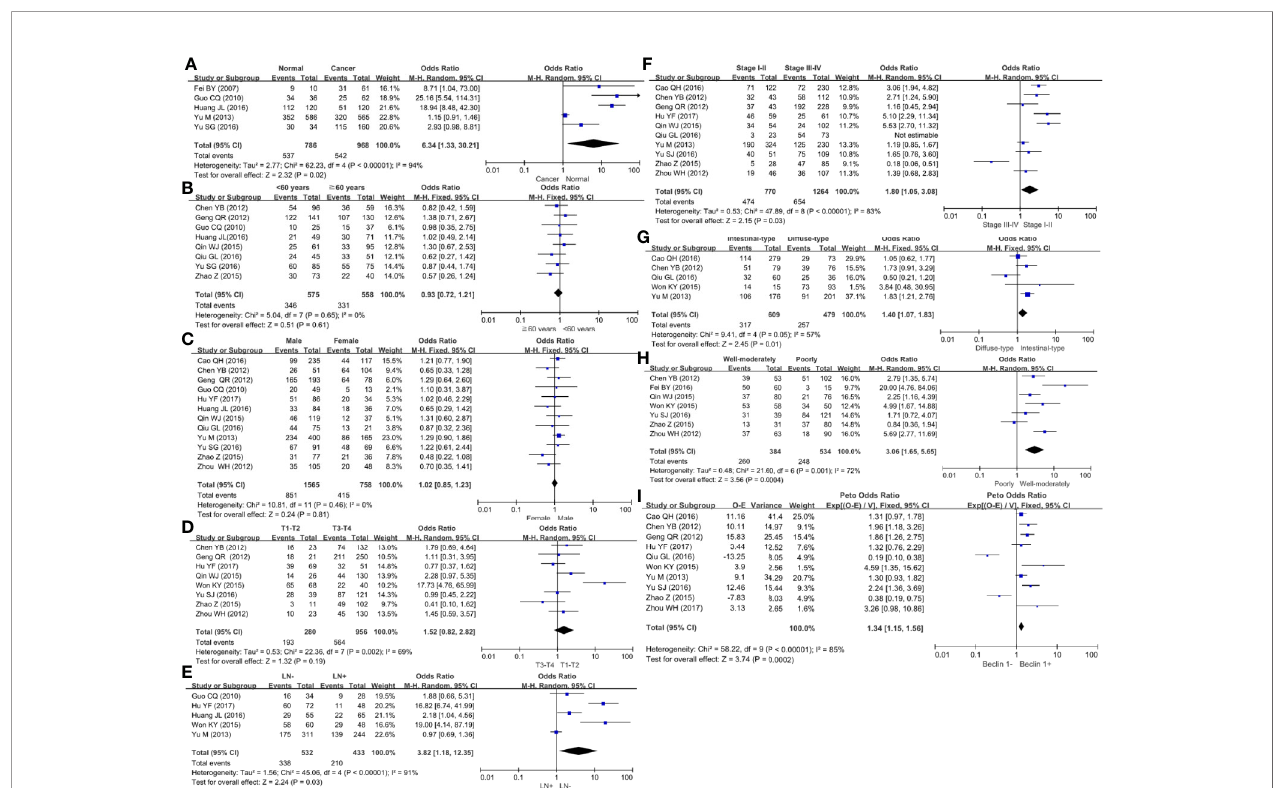
FIGURE 5 | Forest plot for the relationship between Beclin 1 expression and clinicopathological parameters of gastric cancer. (A) gastric carcinogenesis (cancer vs normal mucosa); (B) correlation between age and Beclin 1 expression (<60 years vs ≧ 60years); (C) correlation between gender and Beclin 1 expression (female vs male); (D) correlation between T staging and Beclin 1 expression (Tis-1 vs T2-4); (E) correlation between lymph node metastasis (LN) and Beclin 1 expression (LN- vs LN+); (F) correlation between TNM staging and Beclin 1 expression (stage I – II vs II – IV); (G) correlation between Lauren ’ s classi fi cation and Beclin 1 expression (intestinal-type vs diffuse-type); (H) correlation between WHO ’ classi fi cation and Beclin 1 expression (Well-moderately differentiated vs poorly-differentiated); (I) correlation between prognosis and Beclin 1 expression (Beclin 1- vs Beclin 1+).